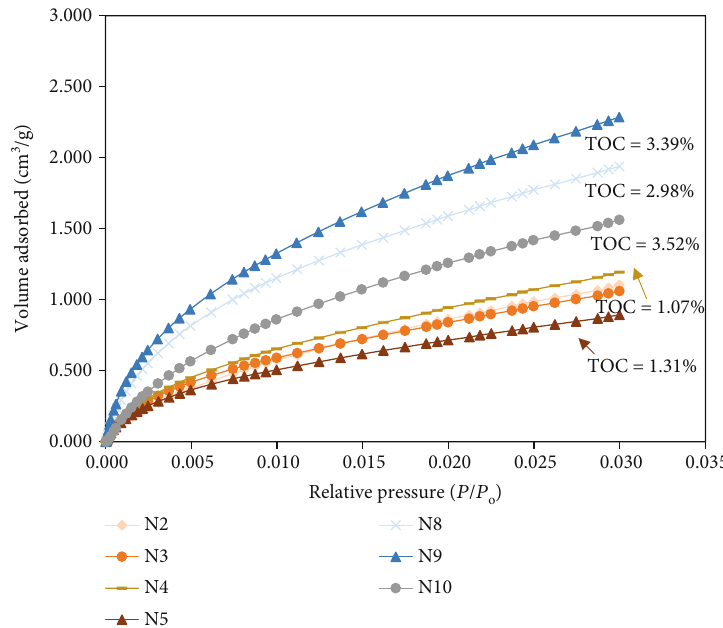
Figure 13: Low-pressure CO adsorption isotherms of Wufeng-Longmaxi shales. Note that the largest volumes of adsorbed CO 2 samples (samples N8, N9, and N10) of the highest TOC values. The TOC content is marked near the isotherm lines. P =actual gas pressure; P =vapor pressure of the adsorbing gas. o Table 2: Micropore and macropore volumes and surface areas obtained by CO (MICP) in Wufeng-Longmaxi shale. The total organic carbon content is also listed in the second column from the left side. Sample ID Total organic carbon (TOC) content (wt.